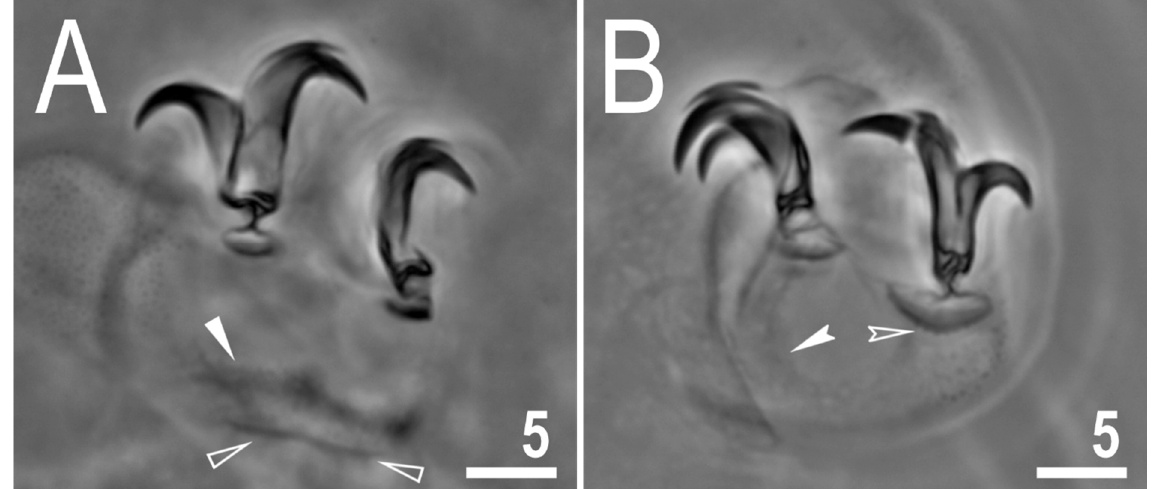
Figure 2. Mesobiotus imperialis sp. nov. —PCM images of claws: ( A )—claw III with smooth lunulae (holotype); ( B )—claw IV with smooth lunulae (paratype). Filled flat arrowhead indicates a single continuous cuticular bar above the claws, empty flat arrowheads indicate paired muscles attachments, filled indented arrowhead indicates horseshoe structure connecting the anterior and the posterior claw, empty indented arrowheads indicate faint dentation in lunula IV. Scale bars in µ